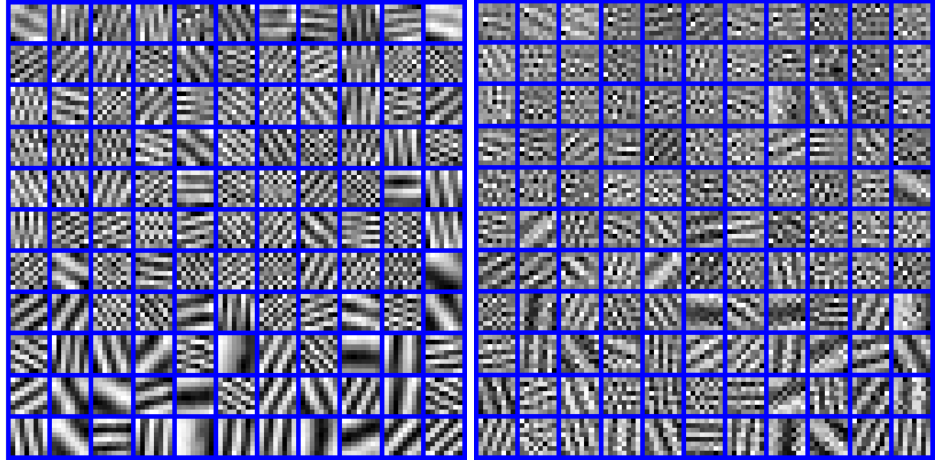
Figure 2. The learnt operators Φ ( left ) and Ψ ( right ) for barbara